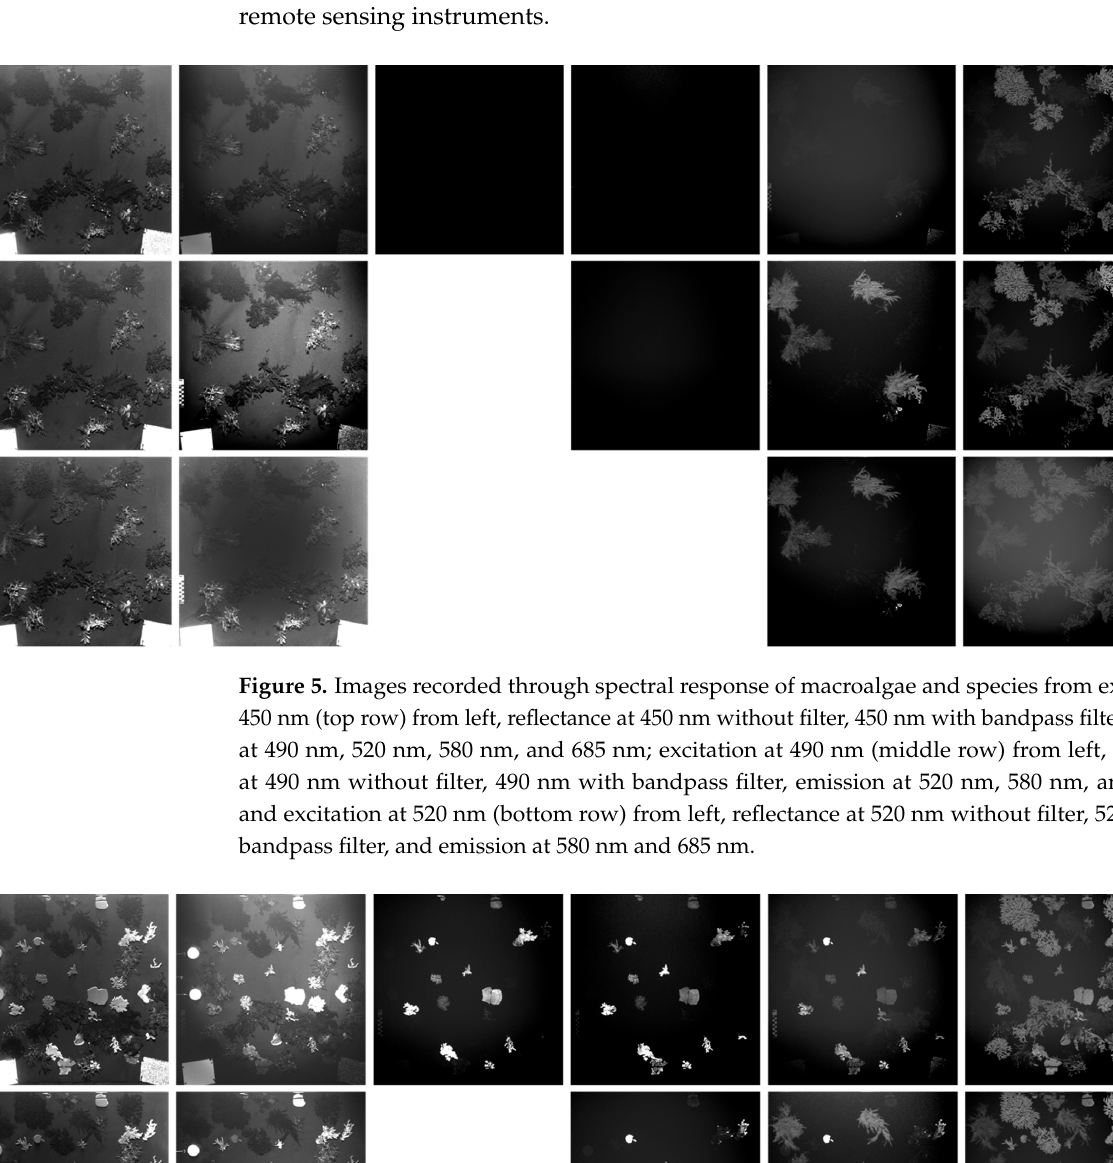
Figure 7. Images recorded through spectral response of macroalgae and coral species, from excita- tion at 450 nm (top row), from left with reflectance at 450 nm without filter, reflectance with band- pass filter, and emission at 490, 520, 580, and 685 nm; excitation at 490 nm (middle row), and from left with reflectance at 490 nm without filter, reflectance with bandpass filter, and emission at 520, 580, and 685 nm, and excitation at 520 nm (bottom row), and from left with reflectance at 520 nm without filter, reflectance with bandpass filter, and emission at 580 and 685 nm.